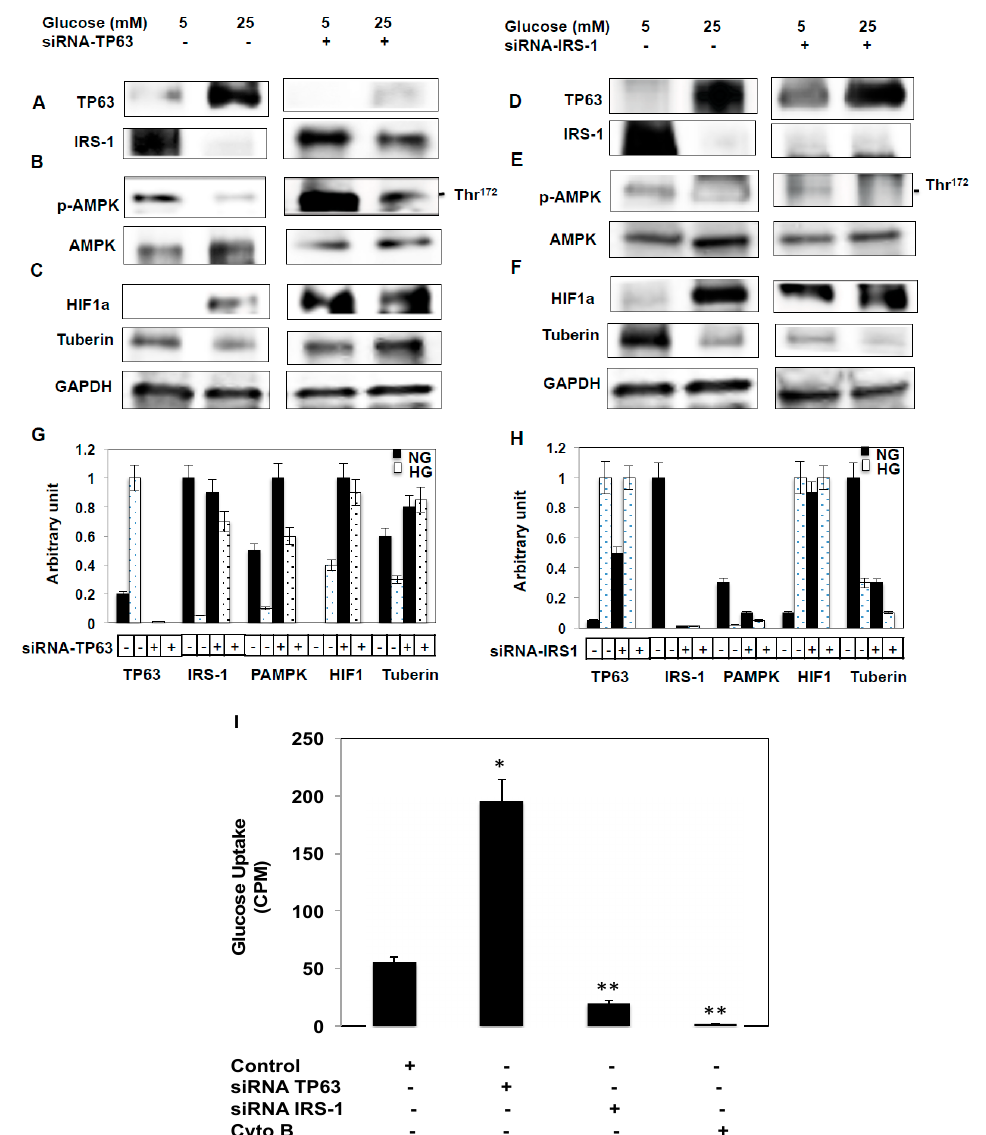
Figure 3. The downregulation of TP63 increases IRS-1, resulting in increased glucose uptake. Mouse tubular (MCT) cells were transfected with siRNA against TP63 or IRS-1 in normal glucose (NG) and high glucose (HG) conditions. ( A ) TP63 is downregulated significantly by TP63 siRNA in both NG and HG. The downregulation of TP63 increased the expression of IRS-1 significantly. ( B ) Both p-AMPK and AMPK were increased significantly by downregulating TP63 in both NG and HG compared to non-transfected cells. ( C ) HIF1a is significantly increased in HG-treated cells, while the downregulation of TP63 resulted in decreased expression of HIF1a. ( D ) The downregulation of IRS-1 by siRNA-IRS-1 in NG and HG resulted in a significant increase in TP63 expression under NG and HG conditions. ( E ) The downregulation of IRS-1 decreased p-AMPK significantly compared to non-transfected cells. ( F ) HIF1a was significantly increased with the downregulation of IRS-1, while tuberin expression was decreased under both NG and HG conditions. ( G , H ) Histogram of average expression of each protein presented as an arbitrary unit was calculated from each protein and normalized by Glyceraldehyde 3-phosphate dehydrogenase (GAPDH) from 2 Western blots. ( I ) Glucose uptake (CPM) is increased by inhibiting TP63 and decreased by inhibiting IRS-1. Cells were transfected either with siRNA-TP63 or siRNA-IRS-1, resulting in an increase and decrease in glucose uptake compared to the non-transfected cells (control), respectively. Cells treated with glucose transport inhibitor cytochalasin B resulted in complete inhibition of glucose transport. Data presented as means ± SE ( n = 6). A significant difference from non-transfected cells is indicated by * p < 0.01 and from cells transfected with siRNA-IRS-1 or treated with cytochalasin B groups by ** p < 0.001.